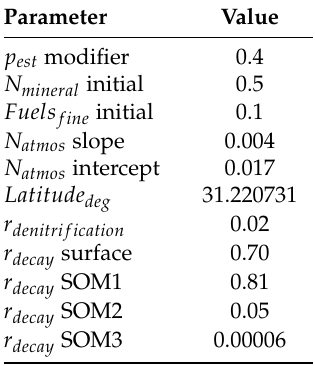
Table A23. NECN adjustment parameters.